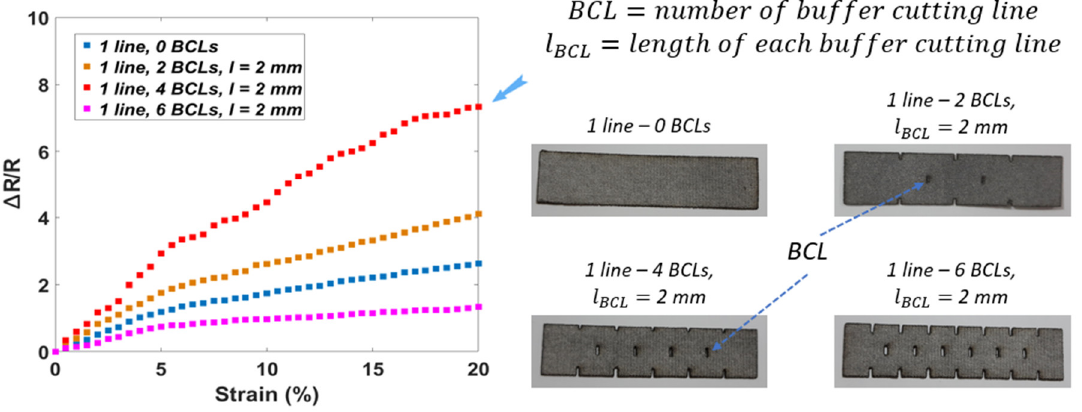
Figure 5. The second in optimizing sensor performances based on the different number of BCLs.